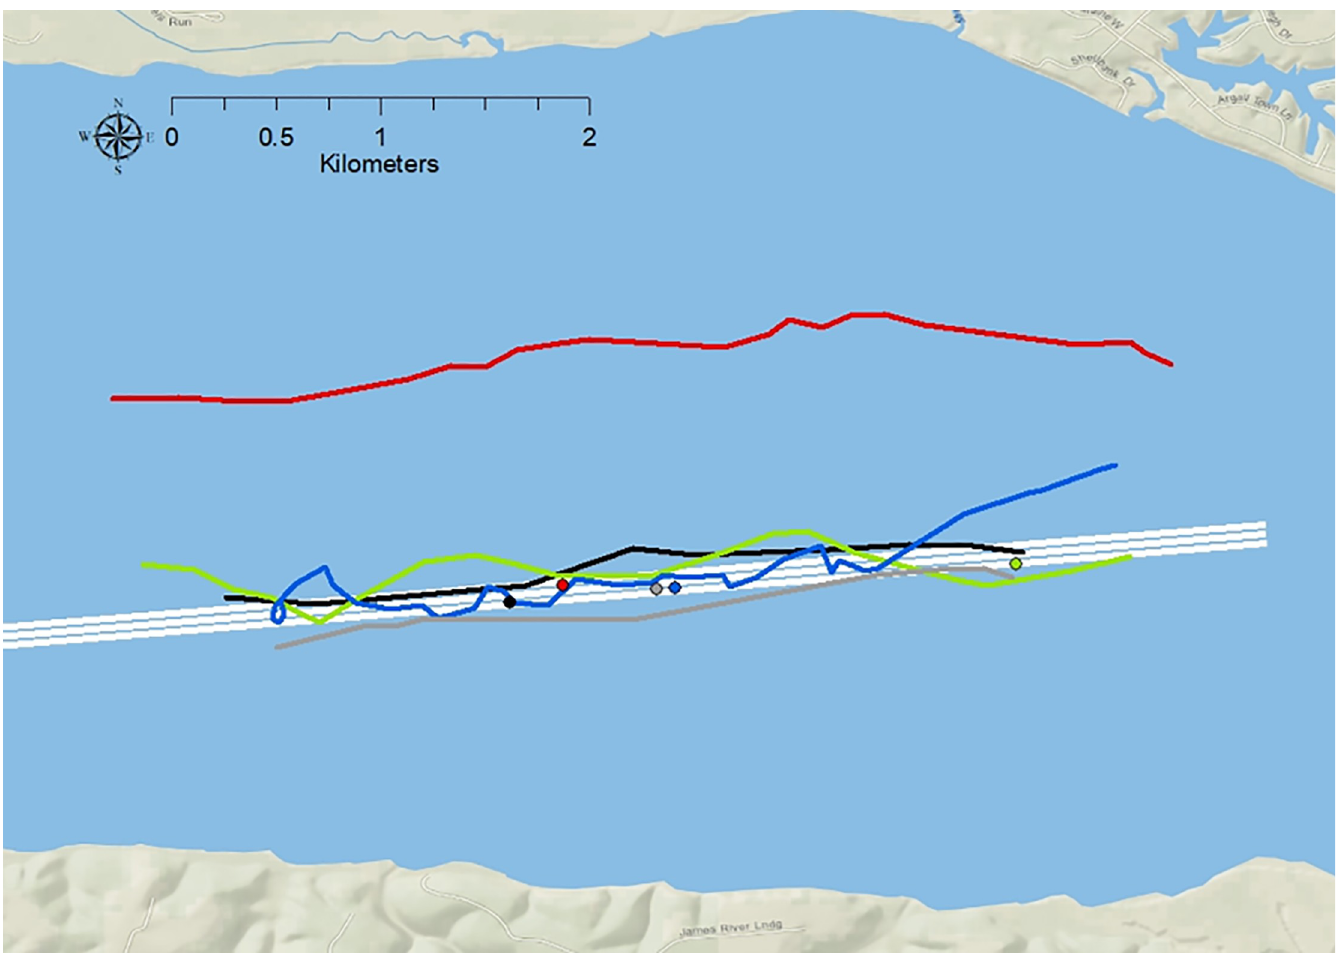
Fig 8. Individual tracks (colored lines) of adult Atlantic sturgeon swimming in an upstream to spawning habitat during dredge operations. The colored dots represent the dredge location for when the sturgeon of the same color line moved through the area. Basemap reprinted from Ocean Basemap under a CC BY license, with permission from ESRI, original copyright 2012.